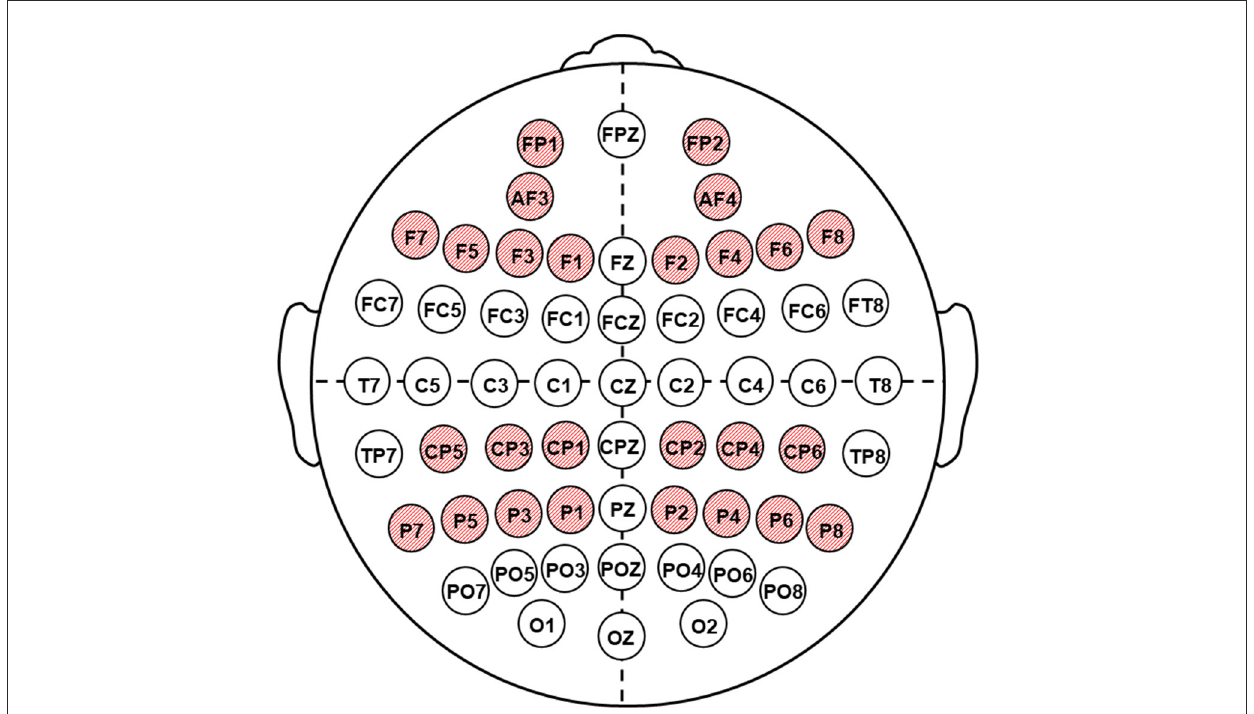
FIGURE2 Location of the electrodes of EEG recording. Shaded red circles indicate the regions of interest (ROI).